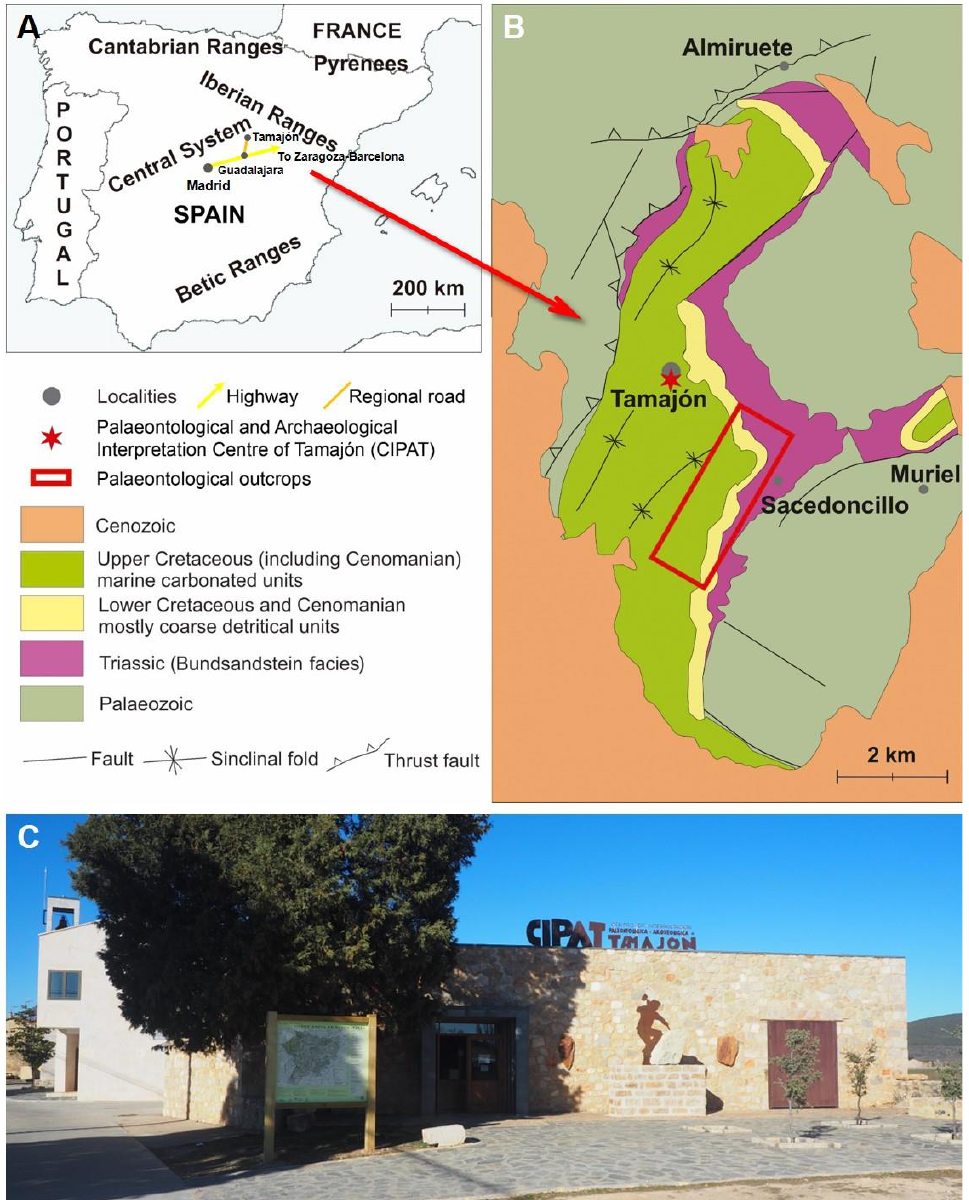
Figure 1. ( A ) Geographical location of Tamajón (Guadalajara, Spain) in the context of the Iberian Peninsula, with some of the main roads of access to the town; ( B ) Geological context of Tamajón, showing the main stratigraphic intervals and tectonic structures, and location of the “Paleontological and Archaeological Interpretation Centre of Tamajón” (CIPAT) and the main paleontological outcrops; ( C ) Image of the current appearance of the exterior of the CIPAT.